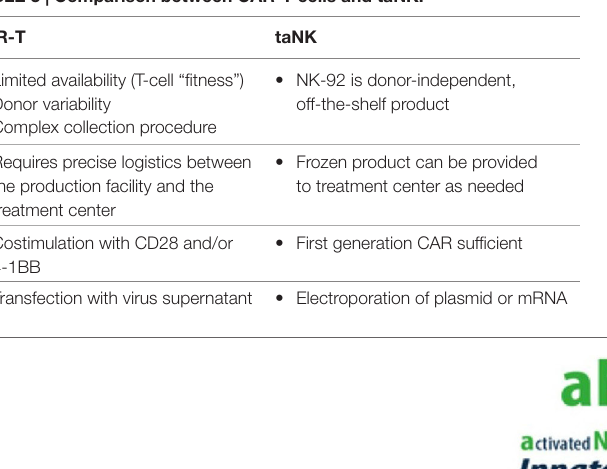
TABLe 3 | Comparison between CAR-T cells and taNK.